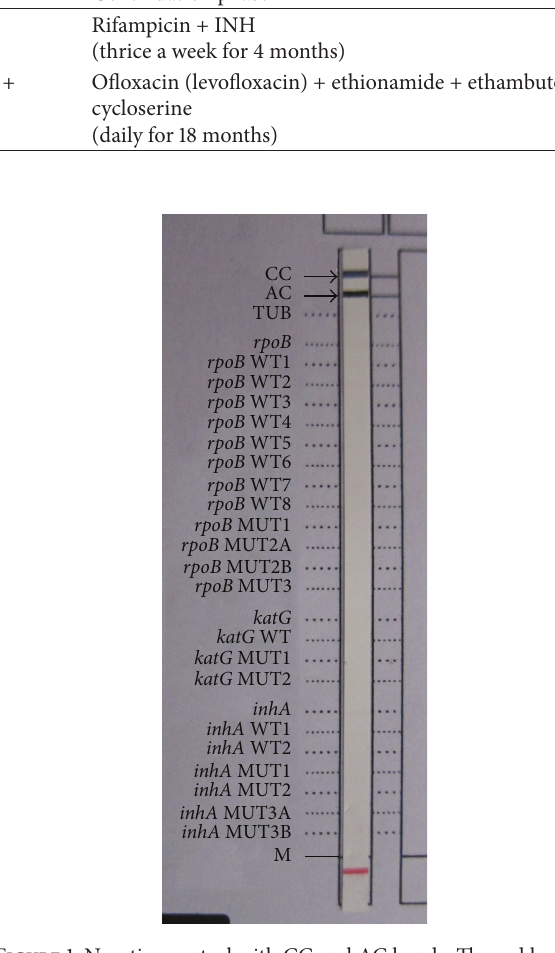
Figure 1: Negative control with CC and AC bands. The red band is reference marker to align the